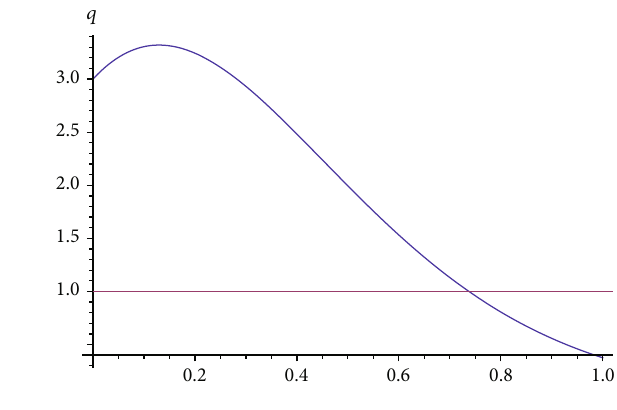
Figure 1: Curve of the condition q with fractional order α .